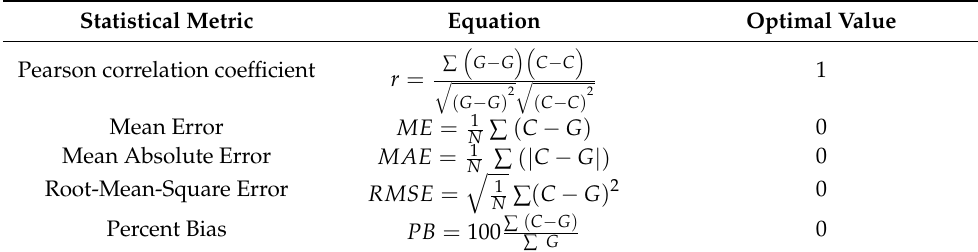
Table 2. Accuracy statistics equations used in the pairwise comparisons between CHIRPS and in-situ